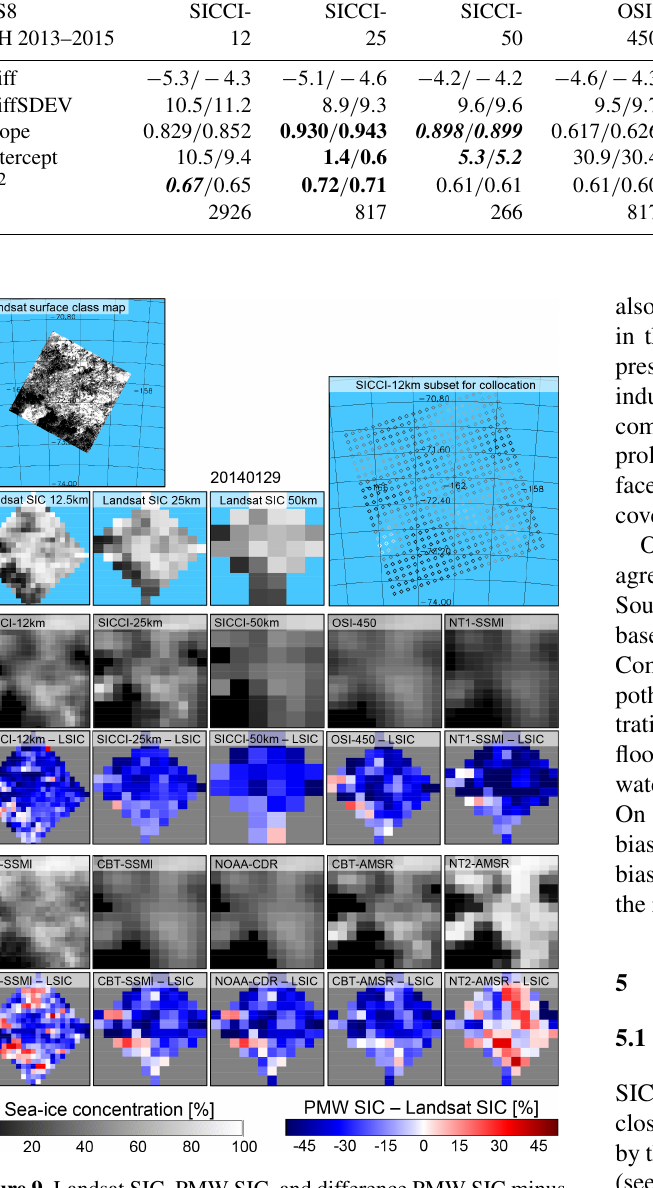
Figure 9. Landsat SIC, PMW SIC, and difference PMW SIC minus Landsat SIC for all 10 products for a melt-condition case in the Ross Sea, Southern Ocean, on 29 January 2014. See Fig. 5 for more description of the maps